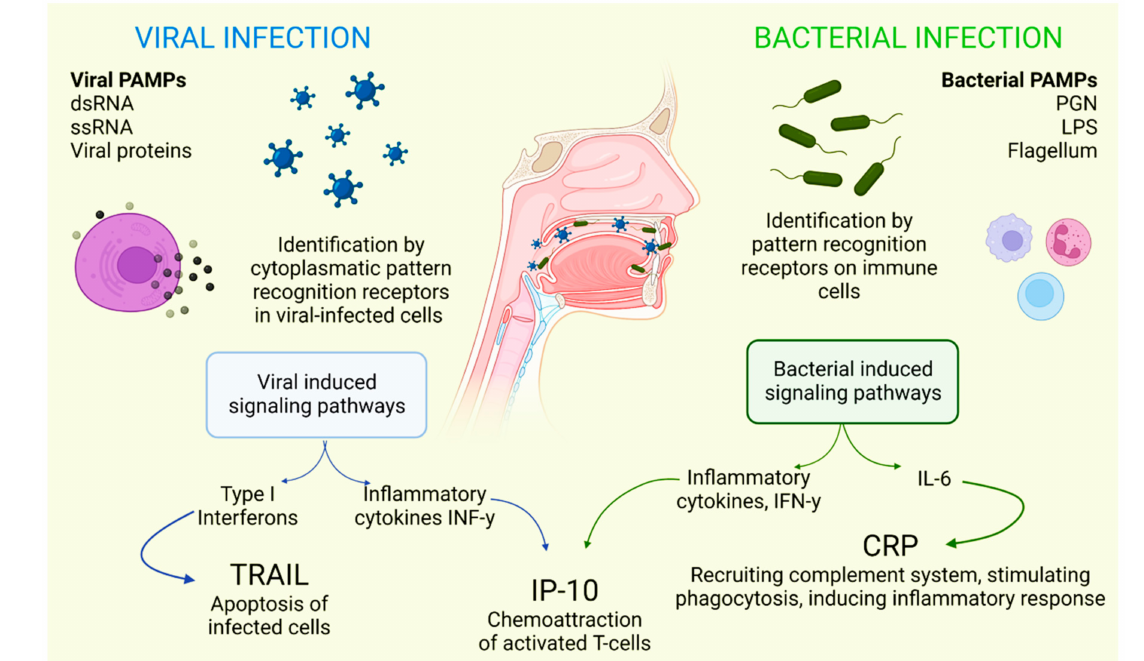
Figure 1. Selective host response against bacterial and viral infections. Different molecules and signaling pathways are dynamically involved in complementing the response to virus and bacterial infections (including CRP, IP-10 and TRAIL). IL-6: interleukin-6; LPS: lipopolysaccharide; PAMPs: pathogen-associated molecular patterns; PGN: peptidoglycan; ssRNA: single-stranded RNA; dsRNA: double-stranded RNA. Adapted with permission from Oved, K. et al. (2015) [32], which was distributed under the terms of the Creative Commons Attribution License https://creativecommons. org/licenses/by/4.0/; accessed date 28 November